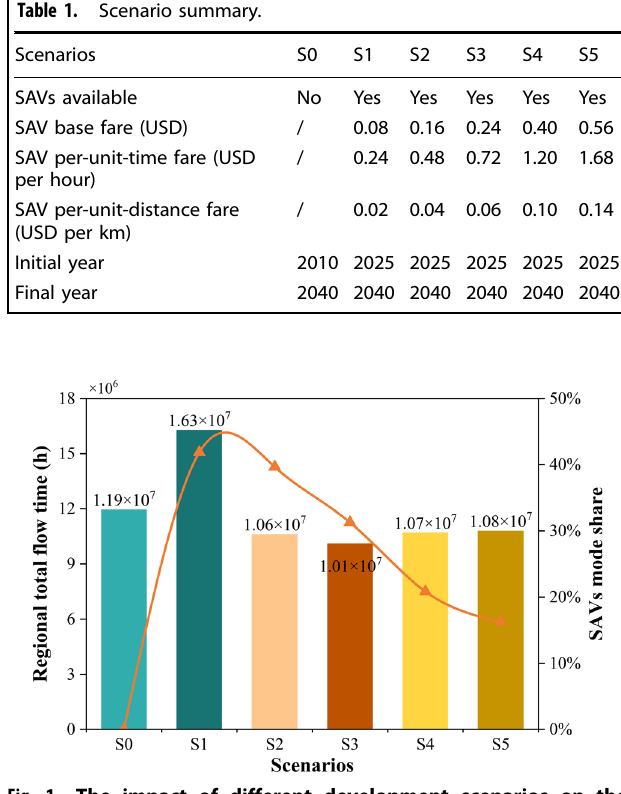
Fig. 1 The impact of different development scenarios on the transportation system. Columns represent the impact of different development scenarios on regional total fl ow time and different colors represent different regional development scenarios. The orange line represents SAV mode share of different development scenarios. It can be found that the low SAV pricing strategy with a higher SAV mode share is the worst scenario among all regional development scenarios in terms of regional total fl ow